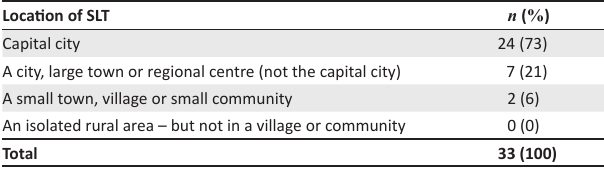
TABLE 3: Location of speech and language therapists.